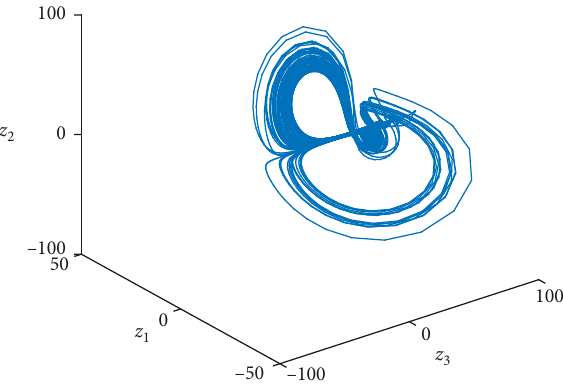
Figure 3: Chaotic attractor of Lorenz system: α � 0 . 92 , τ � 0 .